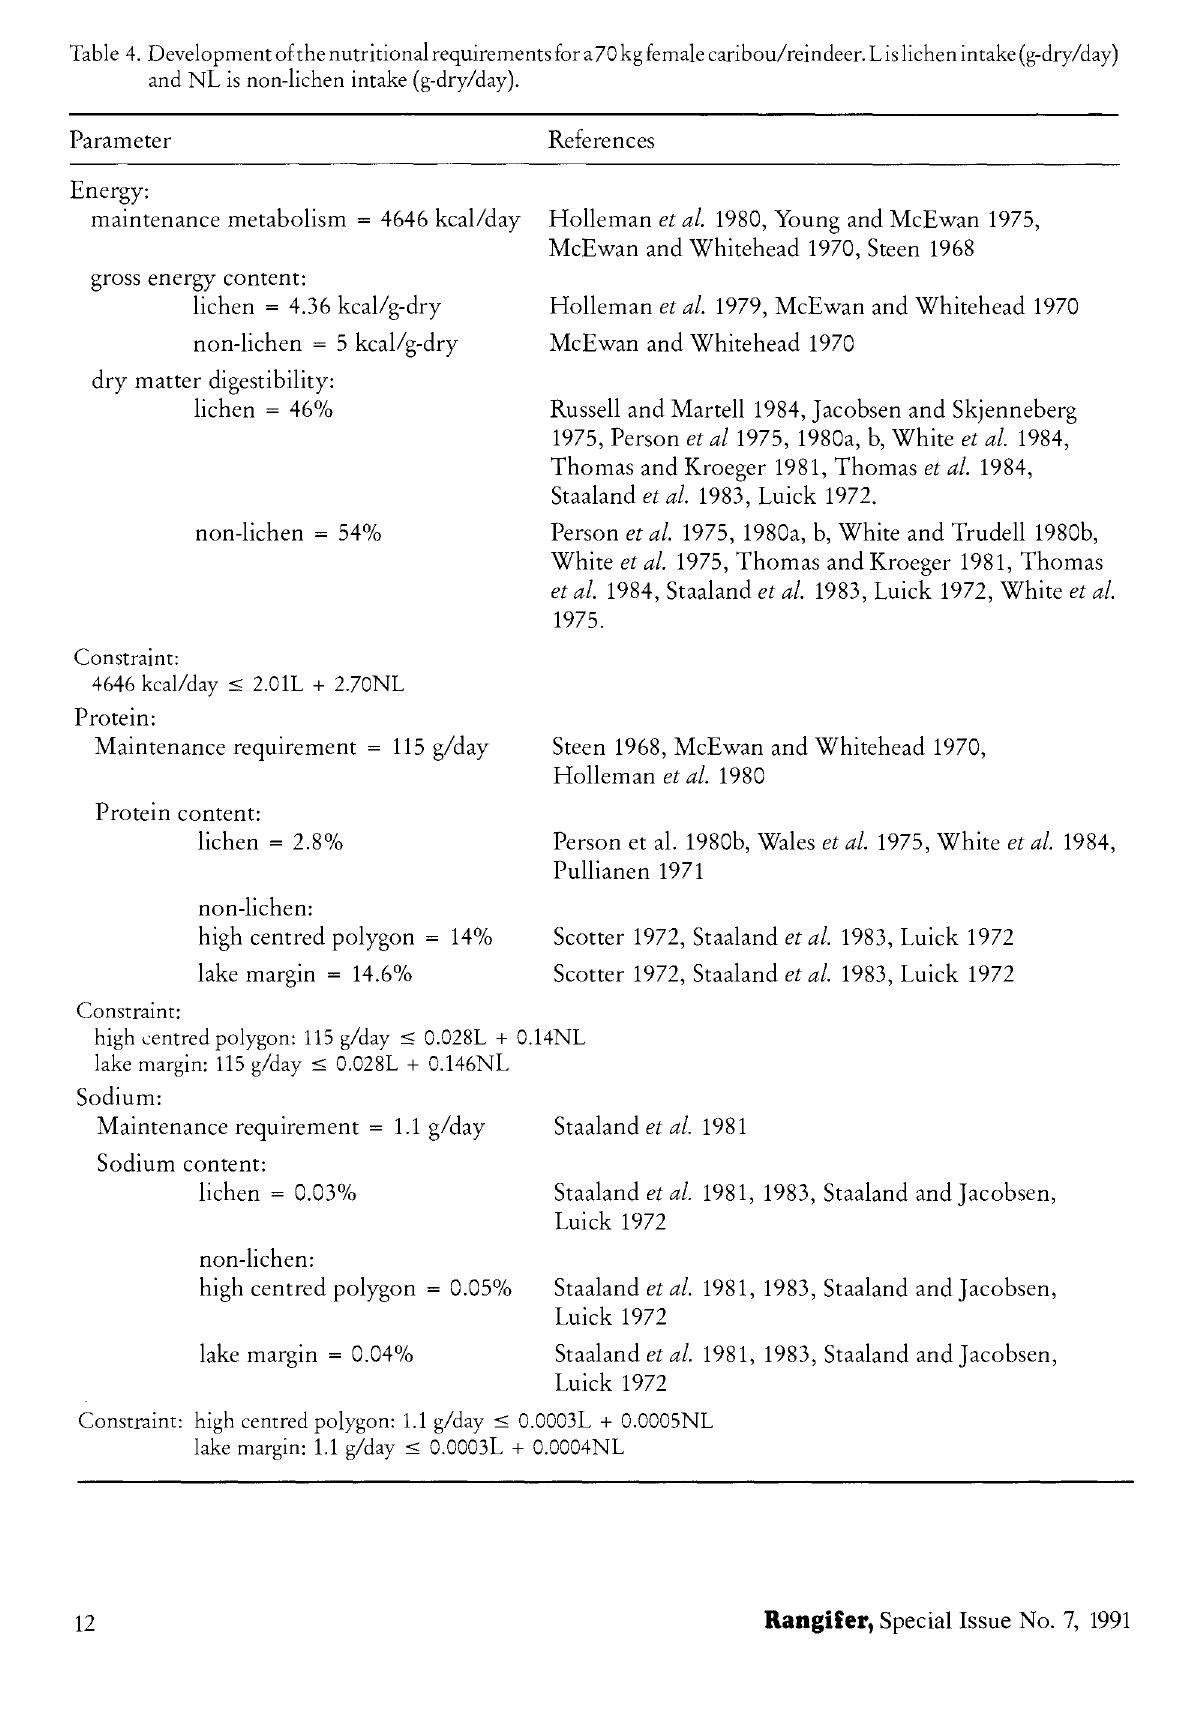
Table 4. Development of the nutritional requirements for a 70 kg female caribou/reindeer. L is lichen intake (g-dry/day) and NL is non-lichen intake